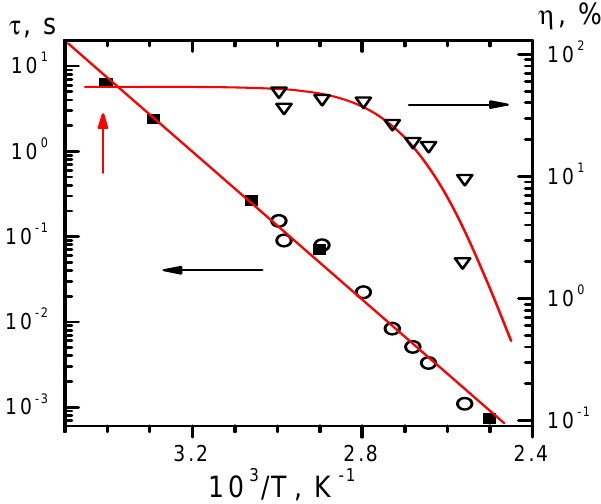
Figure 18. Temperature dependencies of diffraction efficiency (open triangles are experimental data; solid line is the result of calculation based on temperature dependence of the shallow center concentration shown in Figure 6) and the time of ten-fold decay of IR absorption (dark squares) and hundred-fold decay of initial diffraction efficiency :Ga,Y ( N = 5.7 × 10 17 cm − 3 ) crystal by (open circles) of the hologram recorded in CdF 2 Ga pulses of the second harmonics of Nd:YAG laser. The solid line is an approximation of decay data by an Arrhenius plot. Data that correspond to room temperature are indicated by the vertical arrow.